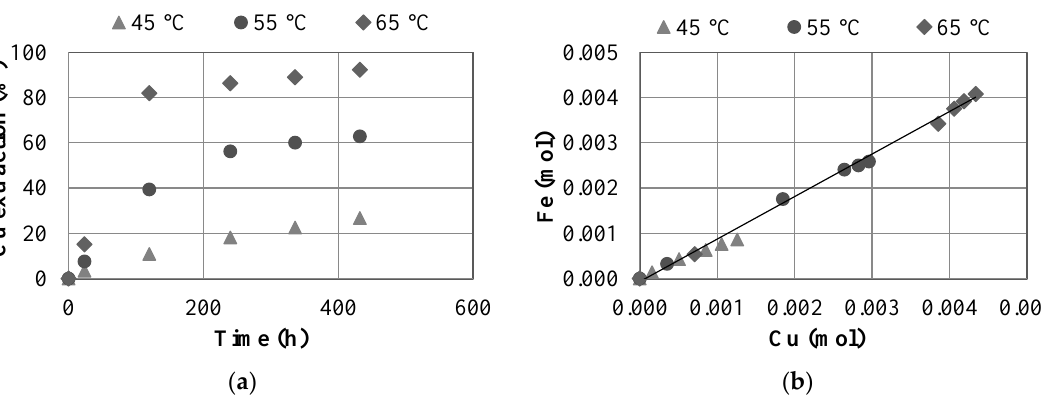
Figure 1. ( a ) Copper extraction (%) versus time (h) at different temperatures: 45 °C, 55 °C and 65 °C. ( b ) Cu/Fe molar ratio at different temperatures: 45, 55 and 65 °C. Experimental conditions: [NaNO 3 ] = 0.7 M, [H 2 SO 4 ] = 0.7 M, seawater as dissolvent, −150 + 75 µ m, S/L ratio 2 g/L, 350 rpm, sample A.